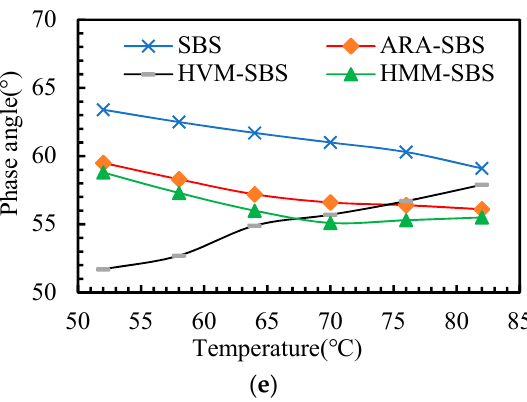
Figure 4. Rheology property of the asphalt binders before aging: ( a ) G*; ( b ) G’; ( c ) G”; ( d ) Rutting factor; ( e ) δ .